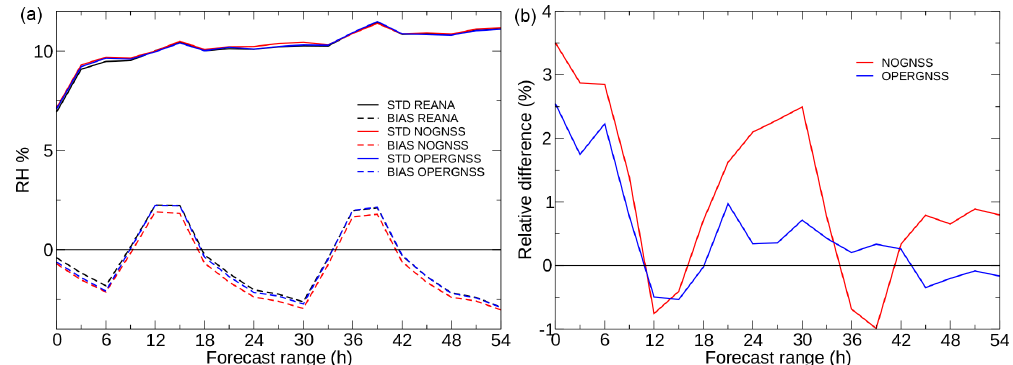
Figure 8. Bias (BIAS; forecast minus observations, dashed lines) and standard deviations (STD; solid lines) computed with relative humidity at 2m (a) and relative root mean square differences (%, b ) with respect to REANA.